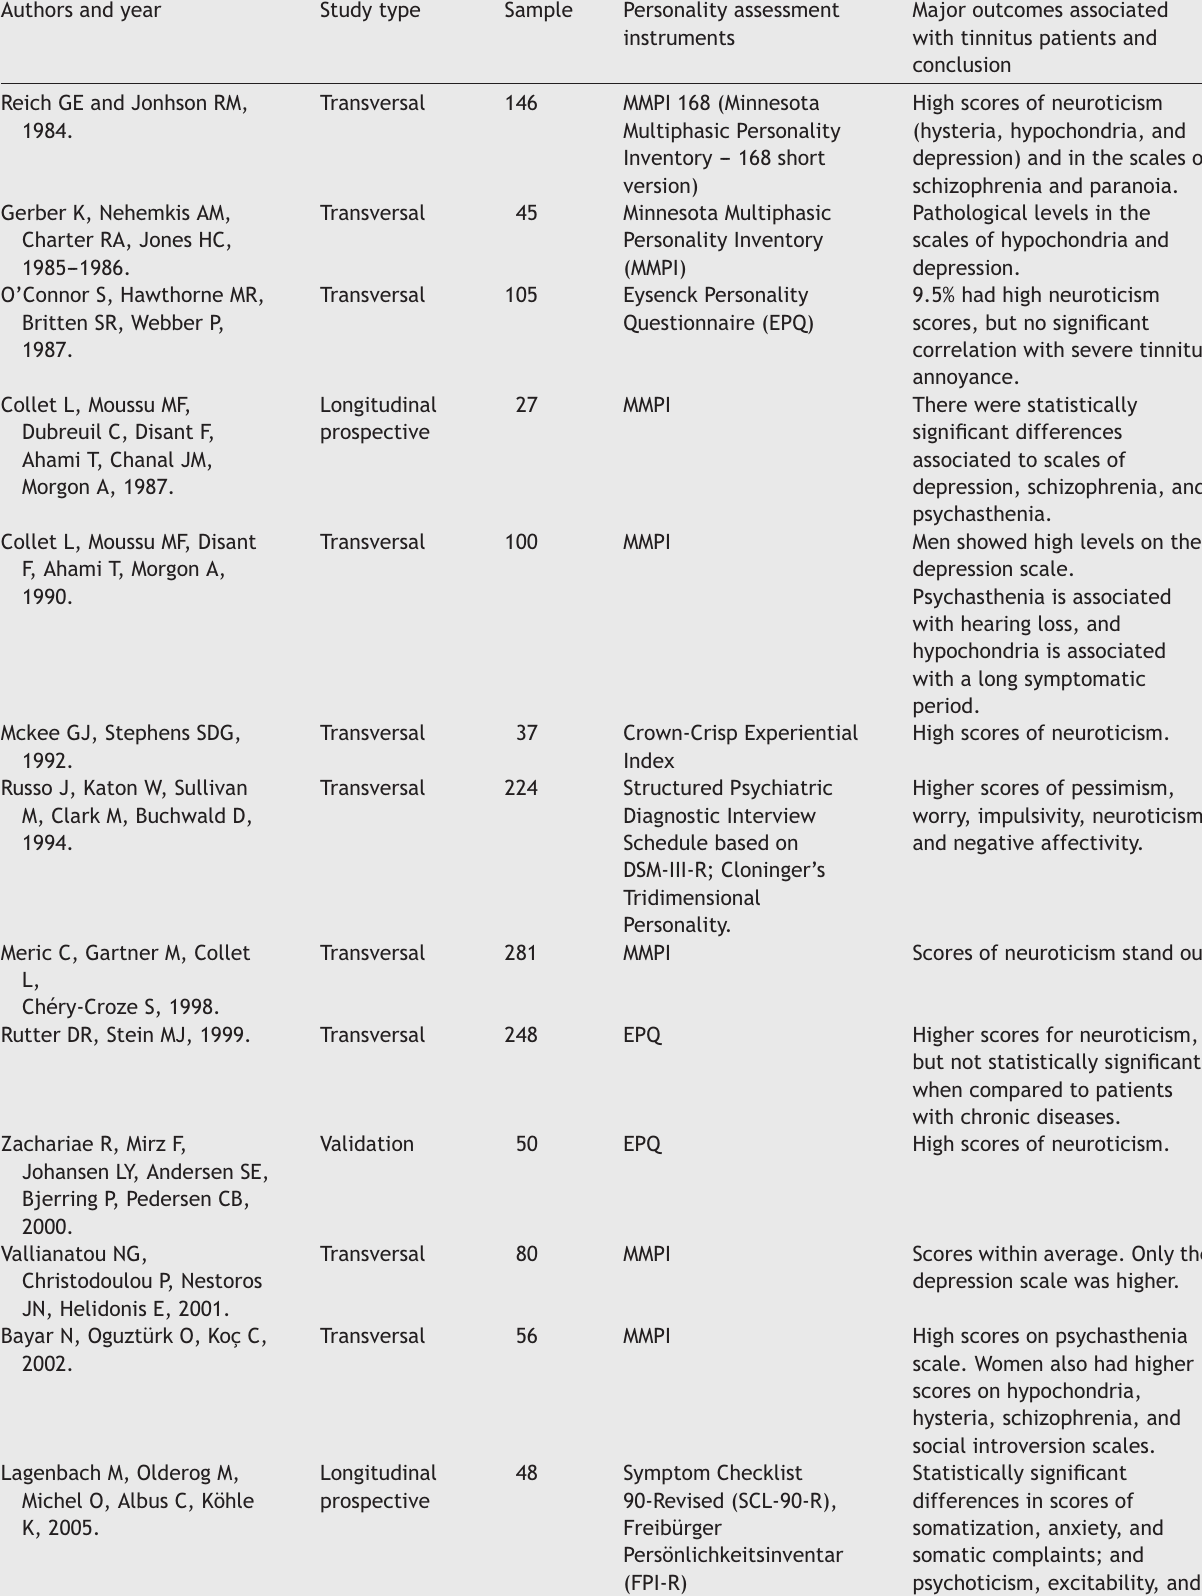
Table 1 Description of papers showing an association between personality and tinnitus regarding the instruments